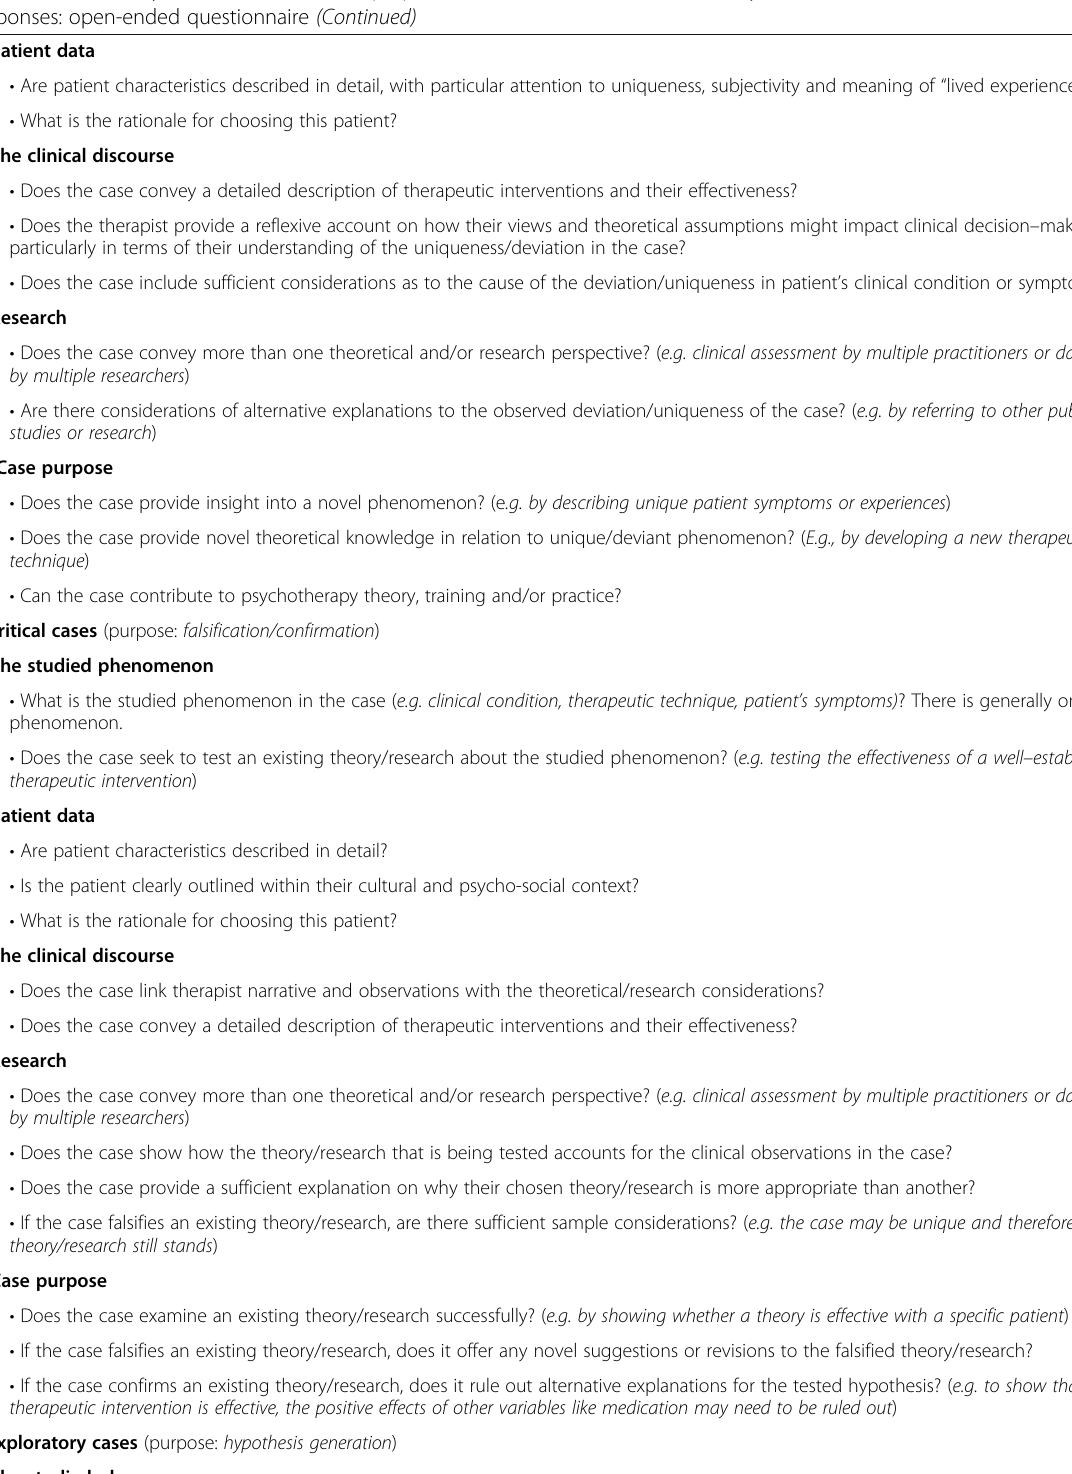
Table 13 Case Study Evaluation-tool (CaSE) purpose-based evaluative framework for systematic case studies.